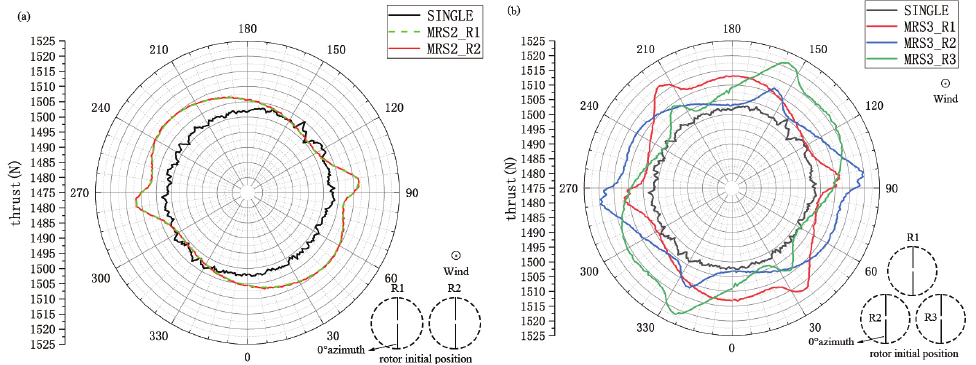
Figure 9. Thrust–Azimuth angle: ( a ) Twin-rotor; and ( b ) tri-rotor wind